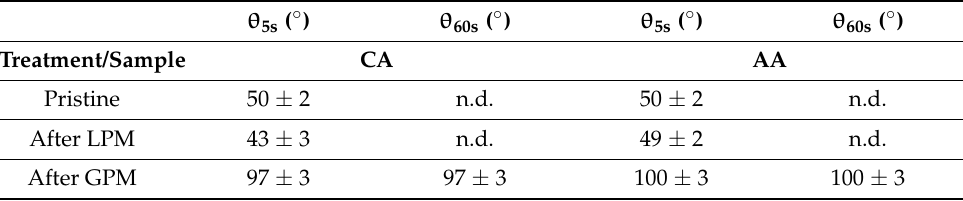
Table 4. Contact angle θ for pristine aerogels and after silanization in liquid phase (LPM) and in gas phase (GPM) at t = 0 s and after 60 s. n.d. means not detectable. θ 5s ( ◦ ) θ 60s ( ◦ ) θ 5s ( ◦ ) θ 60s ( ◦ ) Treatment/Sample CA AA